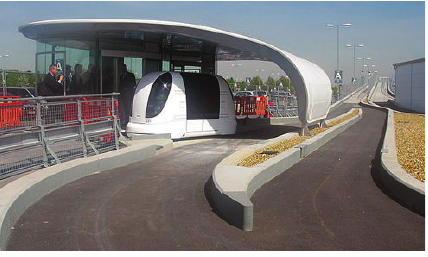
Figure 1: PRT vehicle.